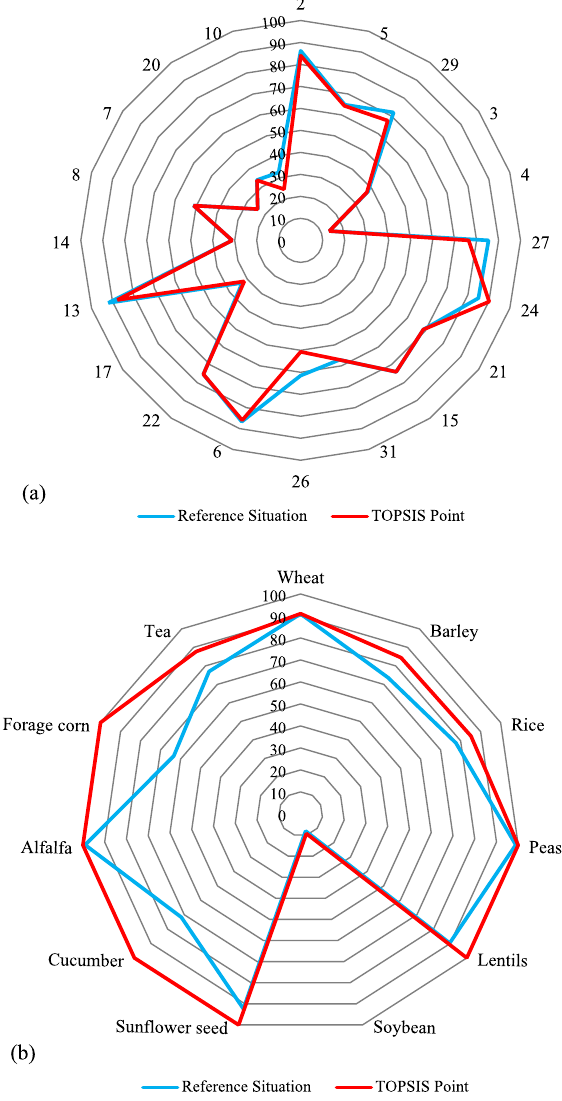
Figure 8. Comparison of water crisis percentage ( a ), and food security percentage ( b ) in the reference and post-modification conditions. Note The numbers in Fig. 9a refer to the province